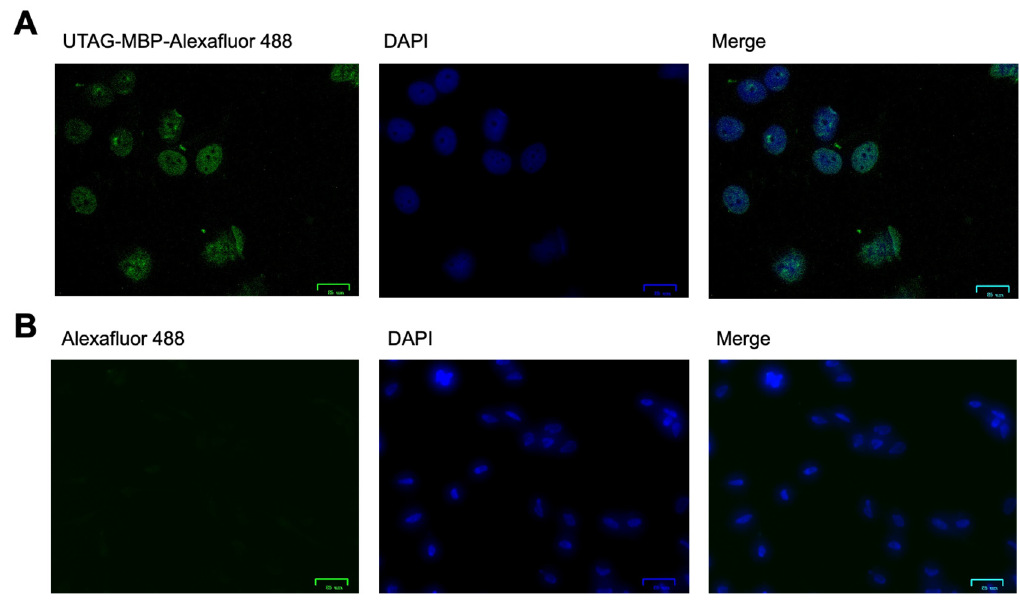
Figure 5. Fluorescence microscopy of Km -UTAG-MBP binding to SUMO in HeLa cells. ( A ) HeLa cells incubated with the Km -UTAG-99- p PrF/AlexaFluor-488 construct demonstrated fluorescence associated with AlexaFluor488 (green) and DNA DAPI stain (blue). Co-localization is observed in the merged image (scale bar = 25 υ M) ( B ) HeLa cells incubated with only AlexaFluor-488 did not display AlexaFluor-488 fluorescence (far left); however, they did exhibit DNA DAPI fluorescence (blue; middle). Only the DAPI is observable in the merged image (far right; scale bar = 25 υ M).